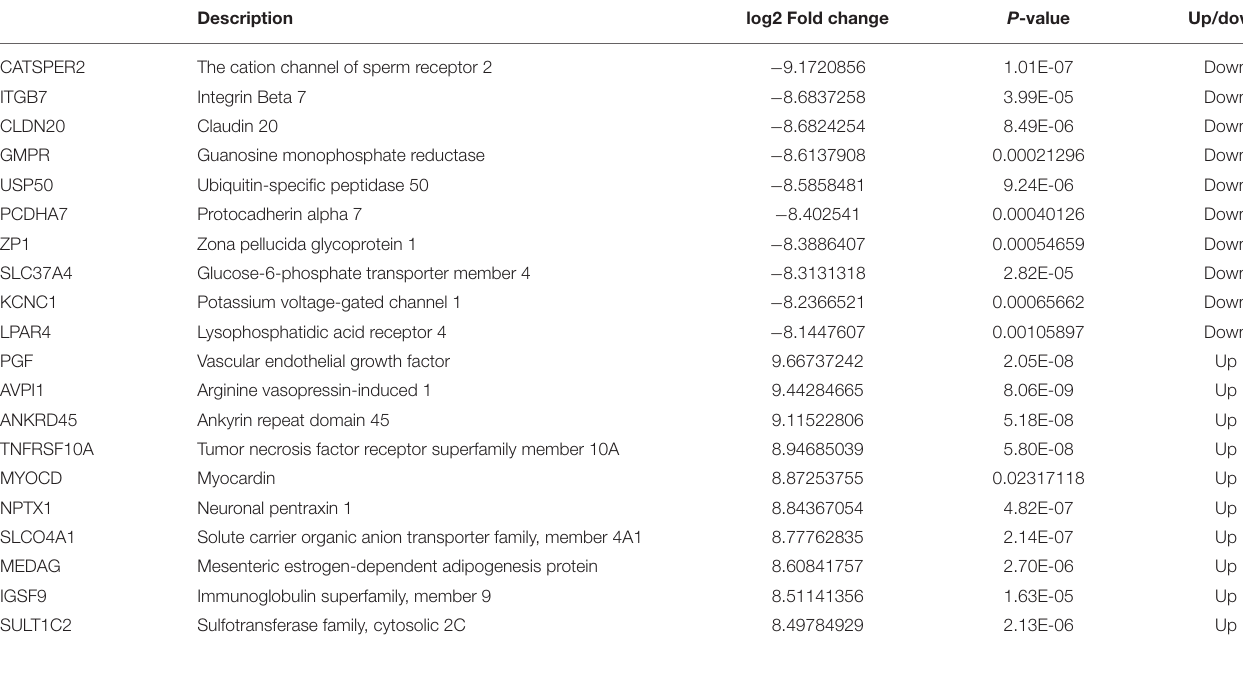
TABLE 2 | List of the top 10 upregulated messenger RNAs (mRNAs) and the top 10 downregulated